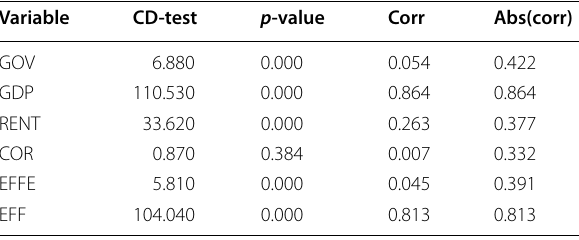
Table 5 Cross-sectional